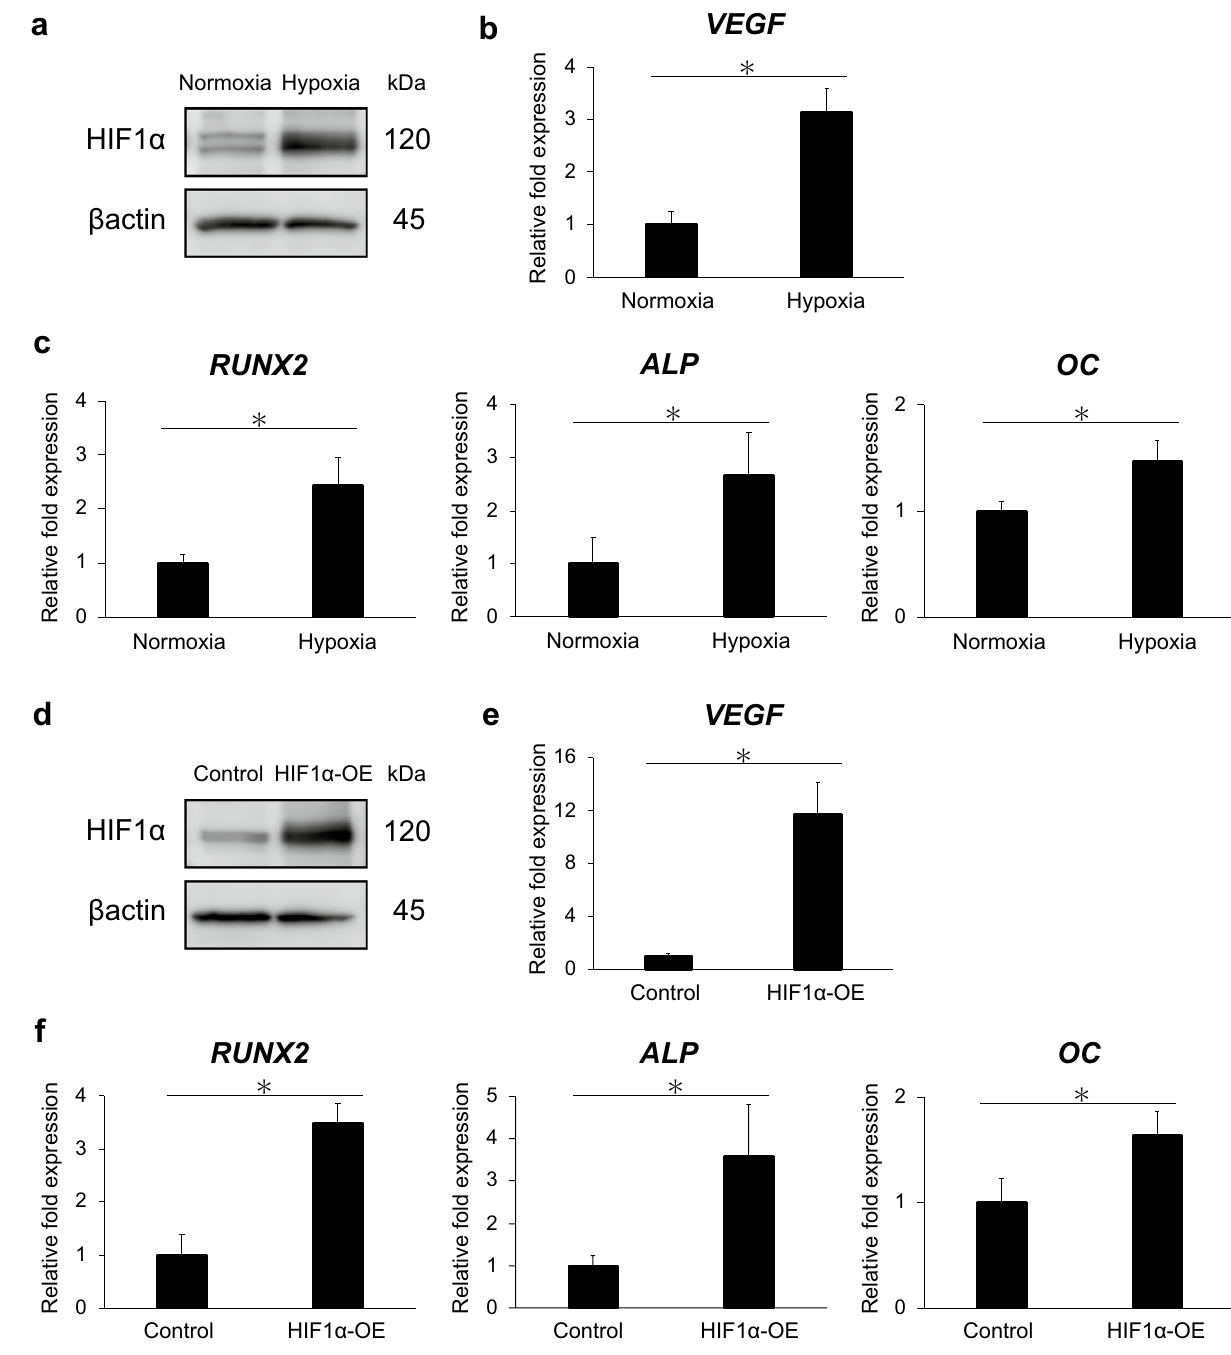
Figure 2. Hypoxia and HIF1α promote osteo/odontoblast differentiation of hDPSCs. ( a , d ) HIF1α protein expression is upregulated in hypoxic culture (1% O 2 ) or upon HIF1α overexpression for 48 h. Full-length blots are presented in Supplementary Fig. 2. ( b , c ) The mRNA expression of VEGF, a HIF1α target gene, and osteo/ odontoblast differentiation markers (RUNX2, ALP, and OC) is upregulated in hypoxic culture (1% O 2 ) for 48 h. ( e , f ) mRNA expression of VEGF, RUNX2, ALP, and OC is upregulated by HIF1α overexpression for 48 h. Error bars indicate standard deviation (n = 4). *p <